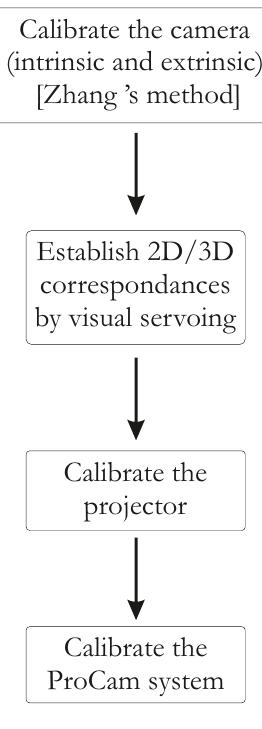
Figure 4. Flowchart summarizing the steps of the full